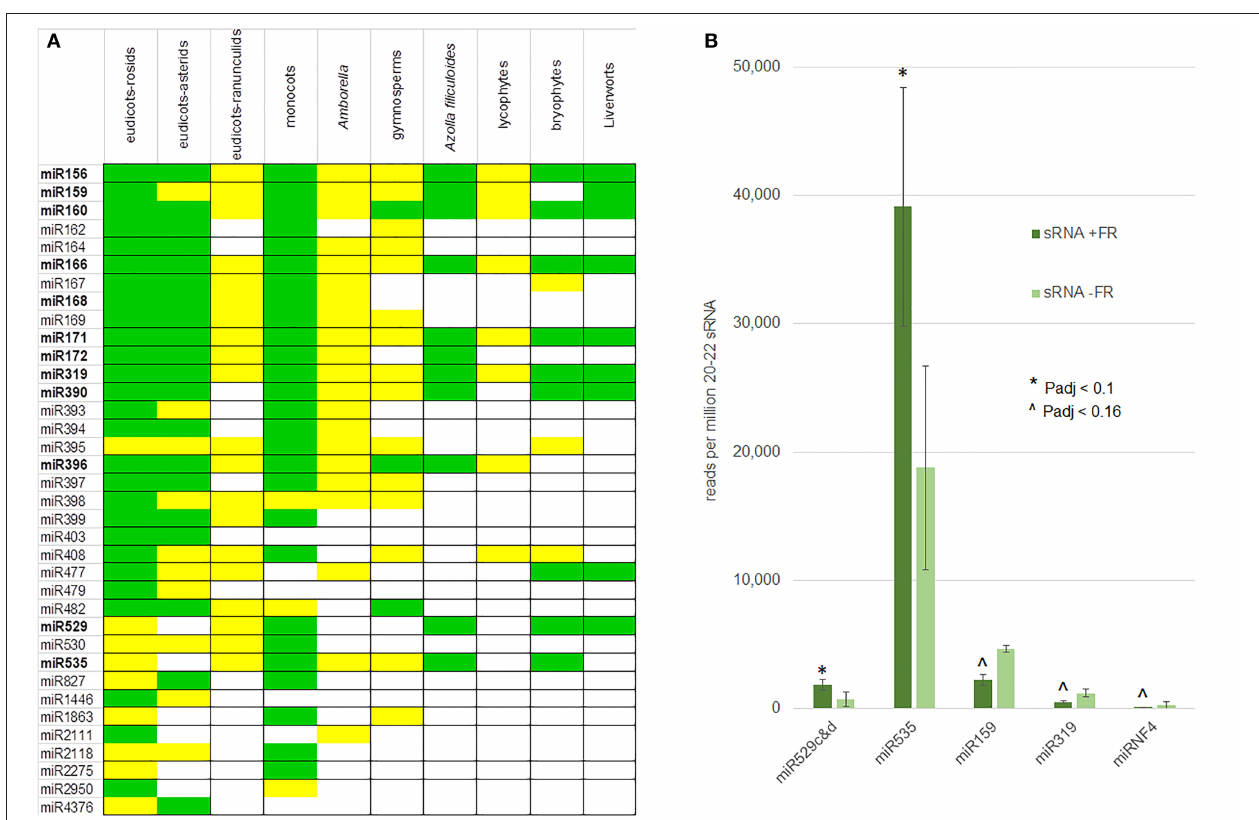
FIGURE 7 | Conserved and FR-responsive miRNA in the fern A. filiculoides . (A) Conserved miRNA in the A. filiculoides fern compared to other land plant lineages. miRNAs from the fern were predicted computationally by miRDEEP-P2 (Kuang et al., 2019) using sRNA-seq reads and then curated manually, the remainder of the table was from Axtell and Meyers (2018). Green, high confidence miRNA; yellow, low confidence miRNA. (B) miRNA with altered steady-state in response to FR light. The average read counts per million 20–22 nt reads in the samples of sporophytes after 1 week on TL with FR (sRNA + FR) or without (sRNA − FR) are shown; raw read counts were submitted to DESeq2 for statistical analyses yielding P -adjusted (P-adj) values: * indicates P adj < 0.1; ∧ indicates P adj <